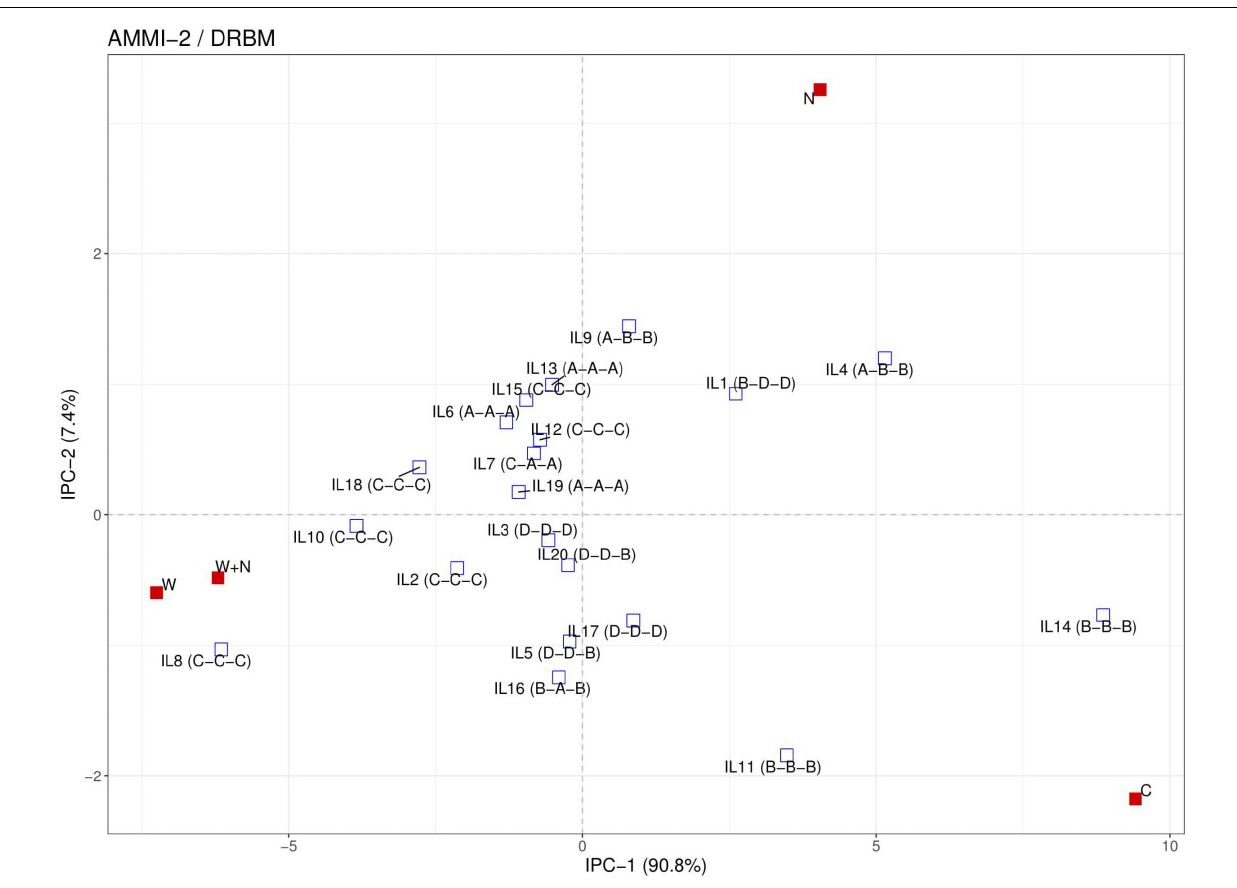
FIGURE 4 | Additive main effects and multiplicative interaction (AMMI) 2 biplot for 20 inbred lines (IL) based on measured dry weight in four treatments (C = control; N = nitrogen stress; W = water stress; N + W = combined nitrogen and water stress). Letters in brackets signify belonging of ILs to the different response groups (from A to D) according to their variation in resilience capacity index and productive capacity index calculated for N, W, and N + W treatment, respectively. Details of the inbred lines are provided in Table 1